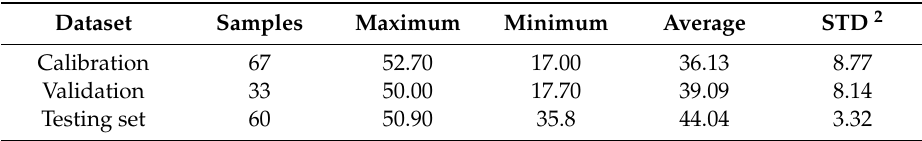
Table 3. SPAD values 1 statistics of calibration set and validation